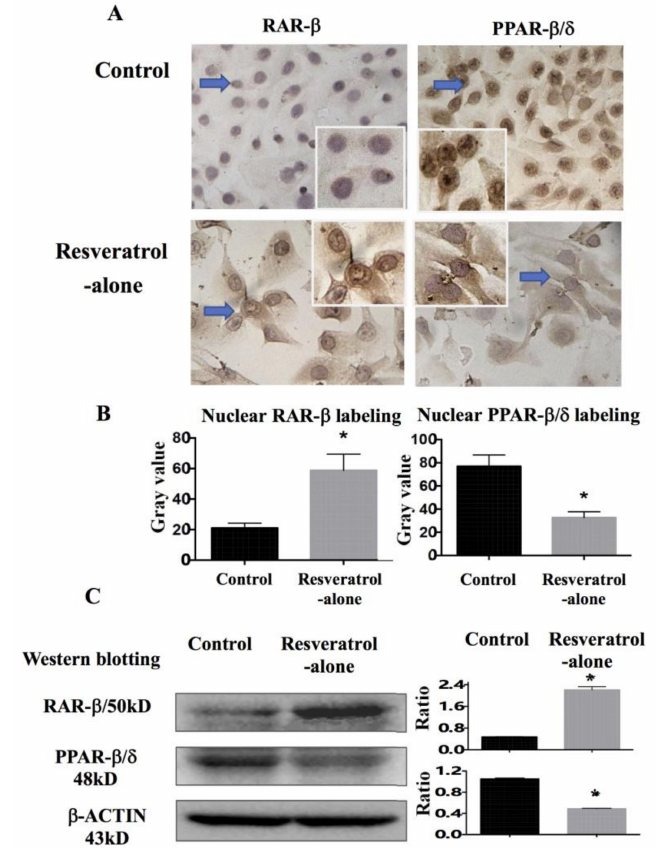
Figure 5. Immunocytochemical and Western blotting demonstration of resveratrol-induced alterations of RAR- β and PPAR- β / δ expression and their intracellular distribution patterns in THJ-11T cells. ( A ) Immunocytochemical staining ( × 40); ( B ) ImageJ-based quantification of nuclear labeling of RAR- β and PPAR- β / δ ; ( C ) Levels of RAR- β and PPAR- β / δ determined by Western blotting. Control, 0.2% DMSO-treated cells; Resveratrol, 48 h 100 µ M resveratrol treatment. Arrows indicate the portions in higher magnification in the insets ( × 80). Ratio, ratio between the levels of the target molecules and that of β -ACTIN; *, with statistical significance ( p < 0.05); NS, no statistical significance ( p > 0.05); the error bars, the mean ± standard deviation. Gray values, nuclear RAR- β and PPAR- β / δ immunocytochemical staining